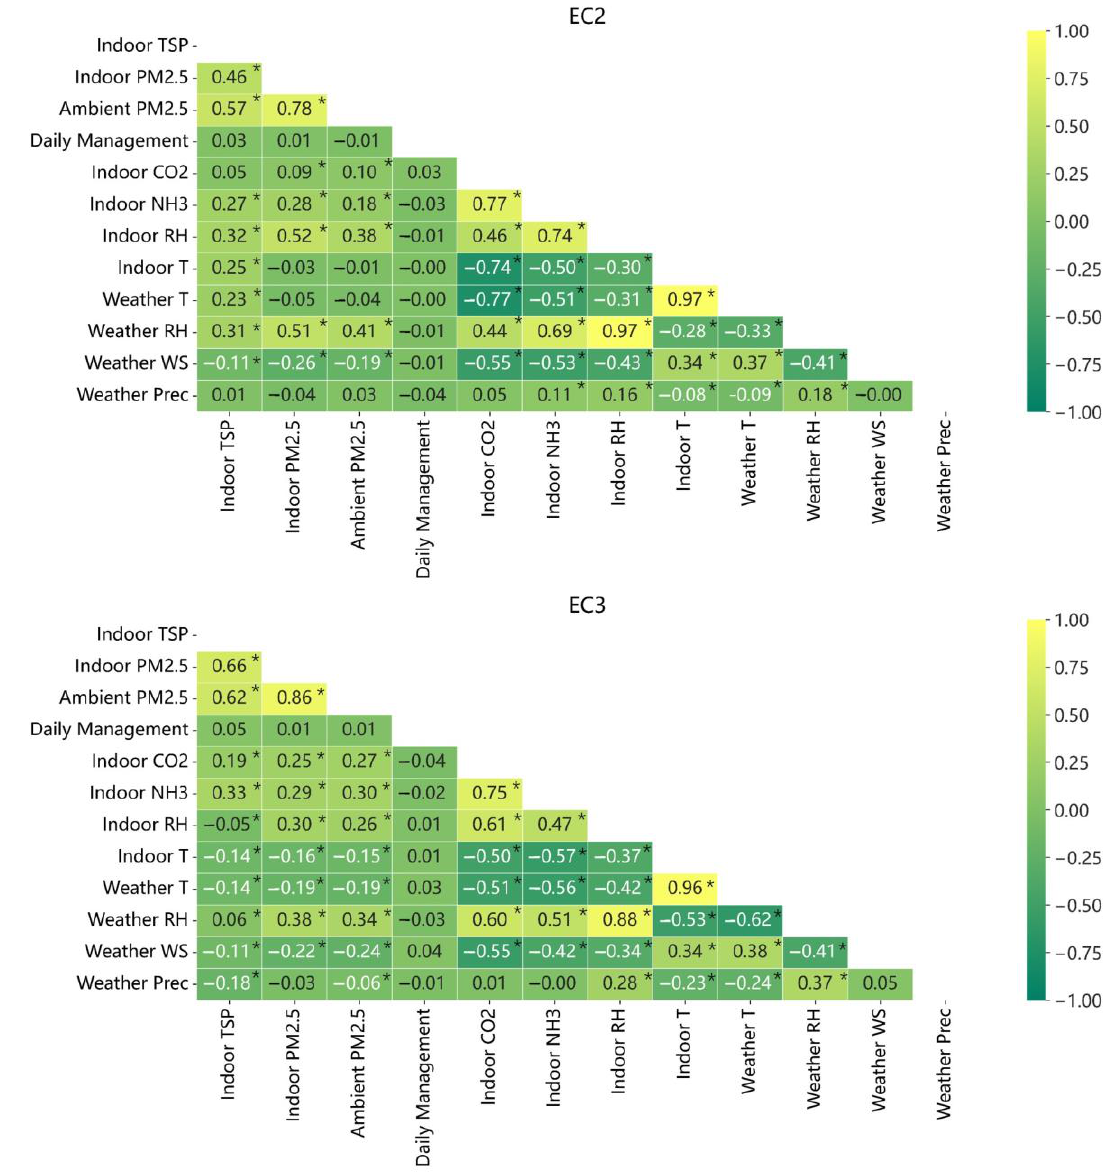
Figure 5. Spearman correlation coefficients between indoor TSP, PM 2.5 concentrations and multiple influencers in three ECs; Indoor T, RH, CO 2 , NH 3 representing the temperature, relative humidity, carbon dioxide, and ammonia concentrations inside the dairy barn, respectively; Weather T, RH, WS, and Prec representing atmospheric temperature, relative humidity, wind speed, and precipitation data from CMA, respectively; Coefficients close to ± 1 represent stronger relationships than values closer to 0, asterisk (*) is significantly different ( p < 0.05).